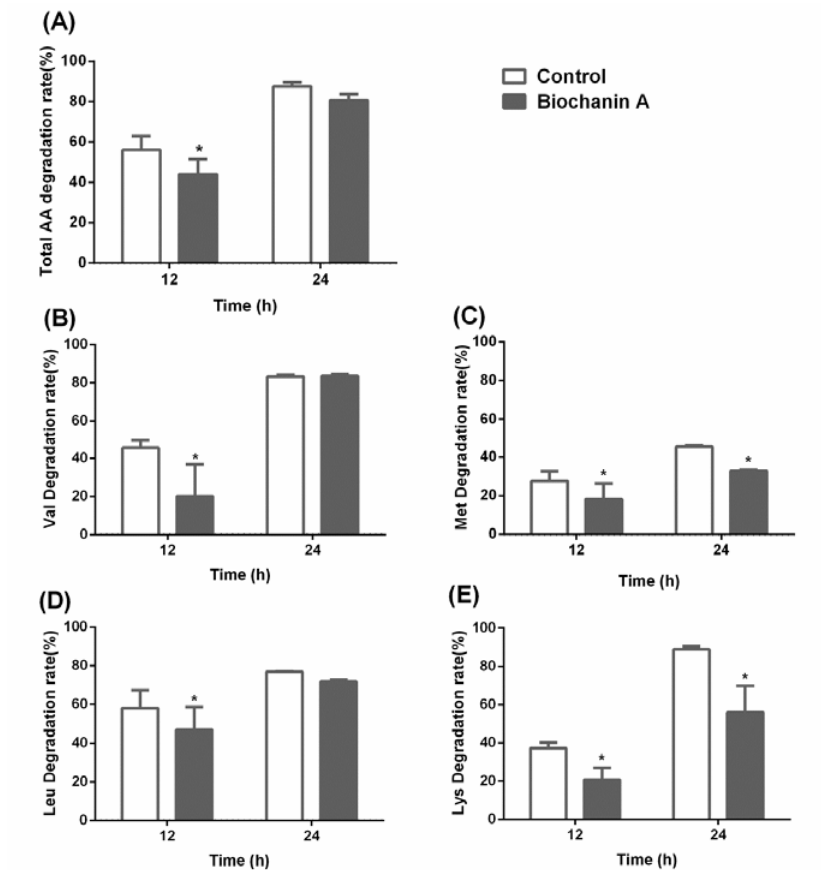
Figure 2. The effect of biochanin A on amino acid degradation rate in culture generation 4. The degradation of total amino acids (AA) ( A ), valine (Val) ( B ), methionine (Met) ( C ), leucine (Leu) ( D ), lysine (Lys) ( E ) during culture incubation. Treatments included controls (only DMSO) and anaerobic medium with exogenous addition of biochanin A. Asterisks (*) indicate a significant difference between treatments ( p < 0.05). Error bars represent SEM.